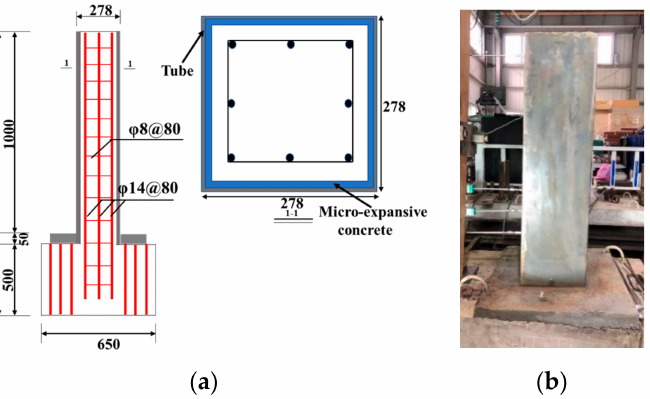
Figure 1. SM-RC dimension diagram and experimental specimen. ( a ) SM-RC dimension diagram. ( b ) SM-RC experiment